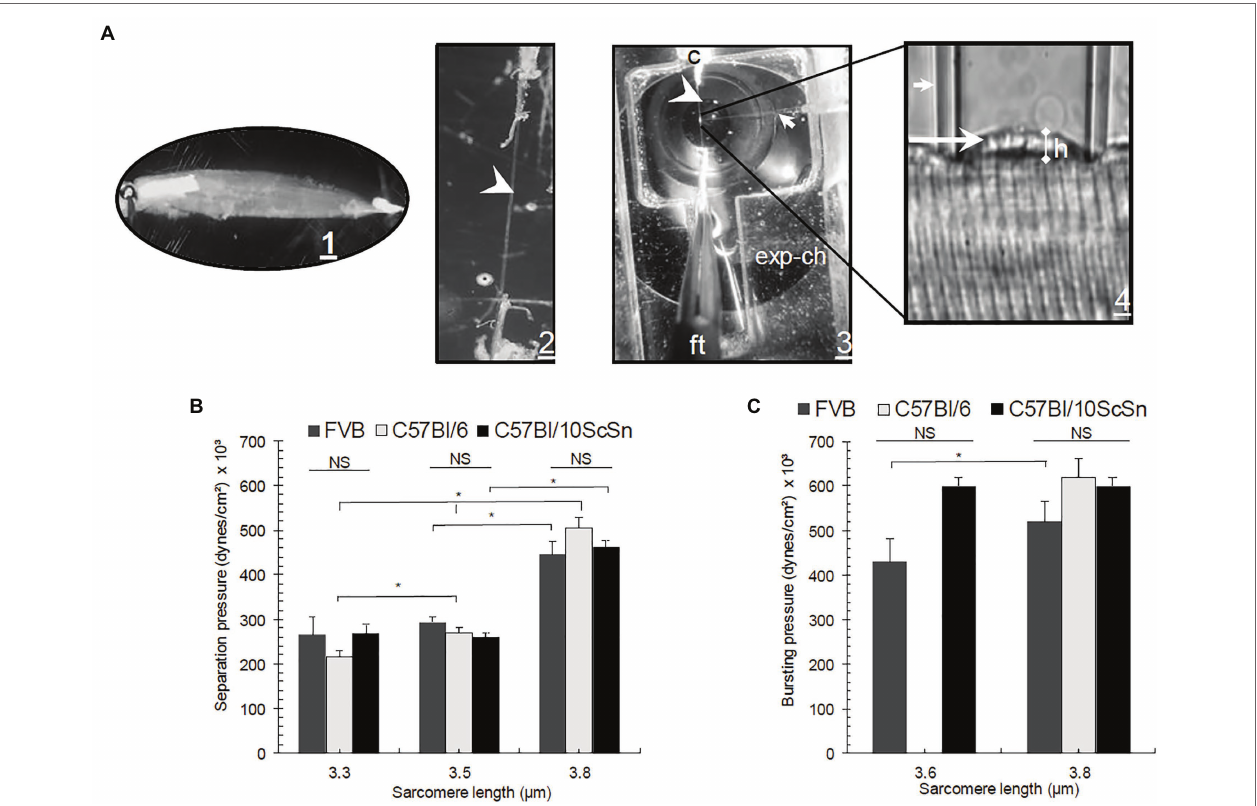
FIGURE 1 | (A1) Experimental procedure for elastimetry measurements. Whole extensor digitorum longus (EDL) is removed with its tendons and placed in Kreb’s solution (in mM:135 NaCl, 5 KCl, 1 MgCl 2 , 15 NaHCO 3 , 11 glucose, 1 Na 2 HPO 4 , and 2.5 CaCl 2 , equilibrated with 95% O 2 and 5% CO 2 , pH 7.0). (A2) The muscle is reduced by teasing to a single isolated fiber in relaxing solution, still attached to its tendons (arrowhead). (A3) The fiber is placed in an experimental chamber (exp-ch), where sarcomere length (SL) is fixed with a clip (c) and fine tweezers (ft). (A4) A borosilicate pipet (small arrow) is placed on the surface of the fiber and negative pressure is applied manually with a Hg manometer attached to a four-key valve to set P inside the syringe, inducing the formation of a bleb (long arrow) of variable height (h). (B) P separation and (C) P bursting graphs in three different control strains: FVB, C57Bl/6, and C57Bl/10ScSn as a function of SL. Bars indicate mean ± SD. *Significant difference within the same control strains at different SL. NS, no significant difference. Statistical analysis was performed with a one-way ANOVA using a Tukey post hoc